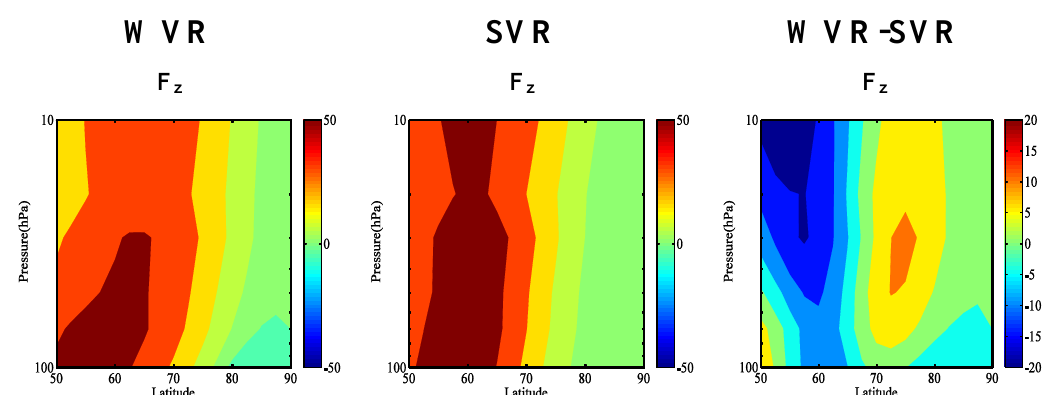
Figure 12. Same as Fig. 11 but restricted to the 100–10hPa range for the vertical component of EP flux. The values are divided by 10 5 . Since (y,z) and Pr Ro (y,z) between WVR and SVR are in the high latitude stratosphere the vertical component the highest differences in the m 2 k,l of EP fluxes are shown in this